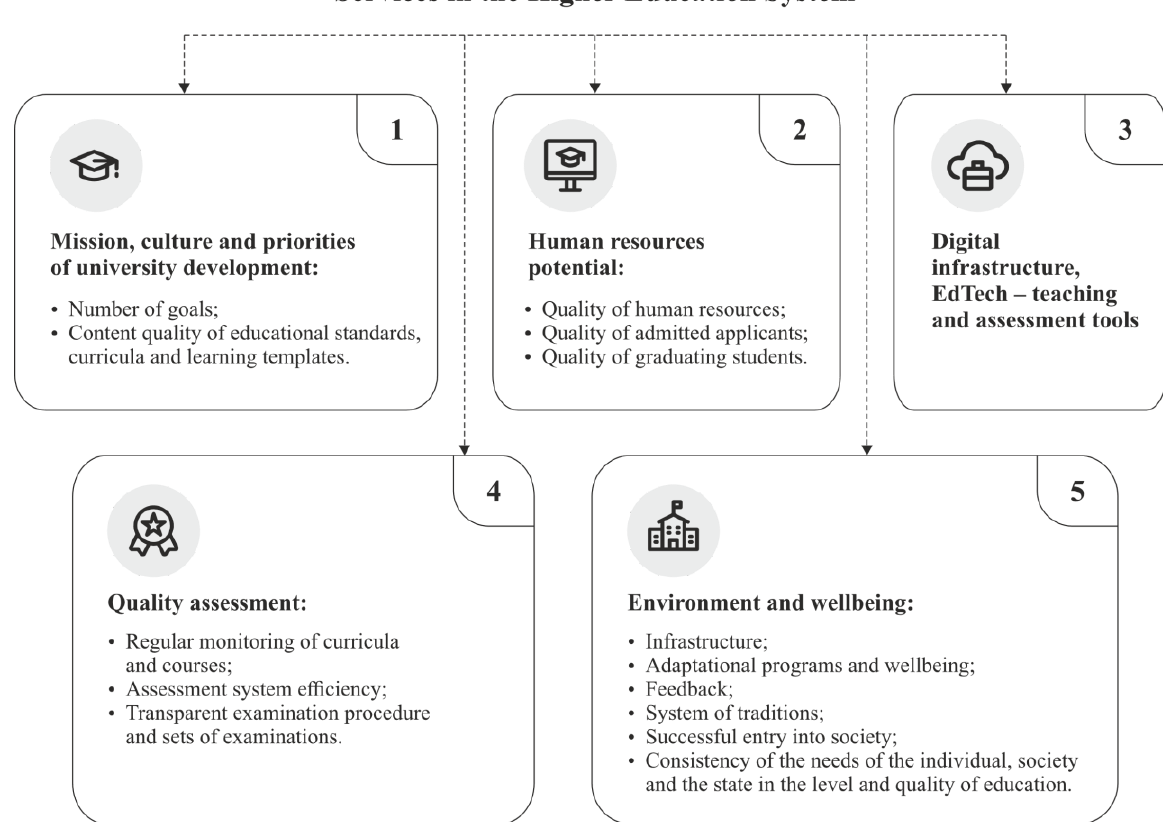
Figure 1. Factors Determining the Quality of Educational Services in Russia’s Higher Education System Description of each factor in